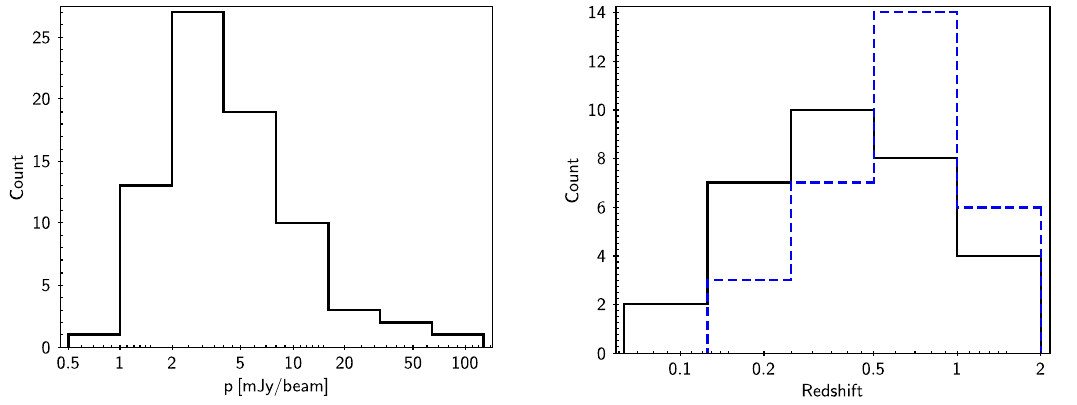
Figure 1. ( Left panel ) histogram of the peak polarised intensity of the 76 polarised sources in LOFAR Two-Metre Sky Survey (LoTSS)-DR1; ( right panel ) histograms of spectroscopic (solid line) and photometric (dashed blue line) redshifts of the polarised